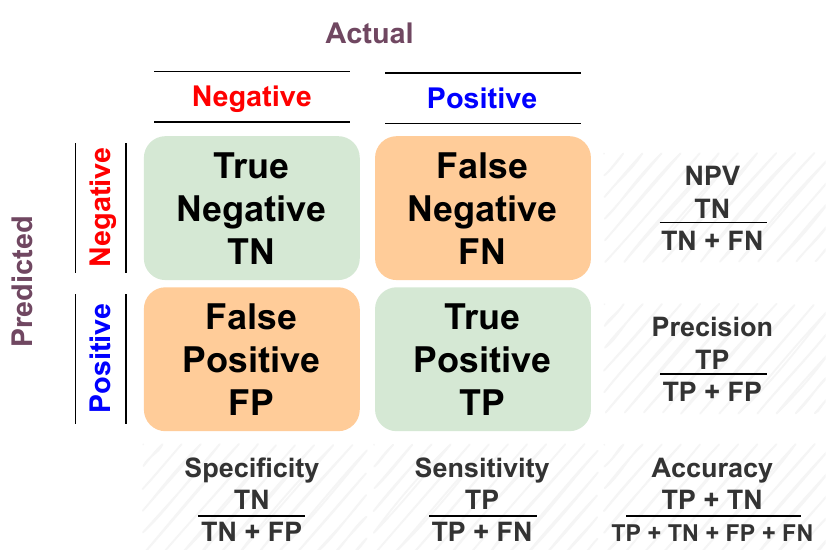
Figure 5. Graphical summarization of the confusion matrix.